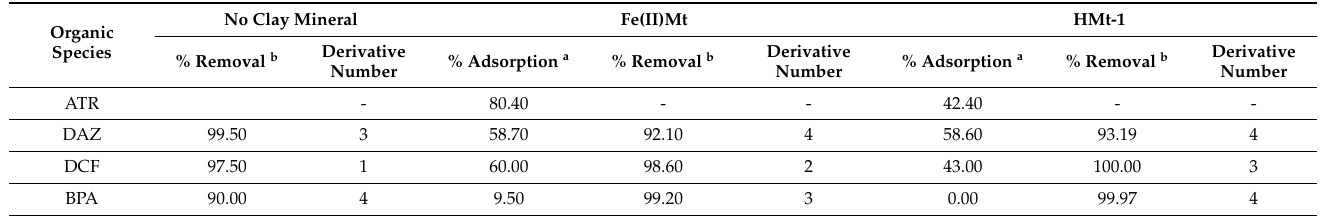
Table 5. Comparison of removal rates (%) by adsorption and conversion by ozone.